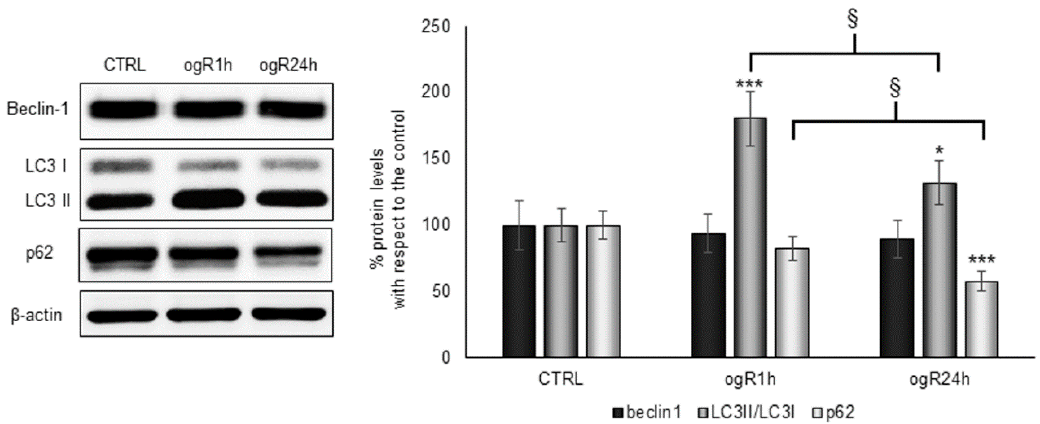
Figure 6. Autophagy marker analysis in RBE4 after OGD/ogR. Cells subjected to OGD/ogR treatment were harvested in lysis buffer, then equal amounts of homogenate samples (as protein) were analyzed by WB. LC3II/I, p62 and Beclin-1 were detected with specific antibodies and revealed by enhanced chemiluminescence (ECL). Sample were normalized on β -actin immunoreactivity. Histograms represent the % of protein levels respect to control as mean ± S.E. from three independent experiments, * p < 0.05, *** p < 0.001 vs. control; § p < 0.05 vs. ogR1h.